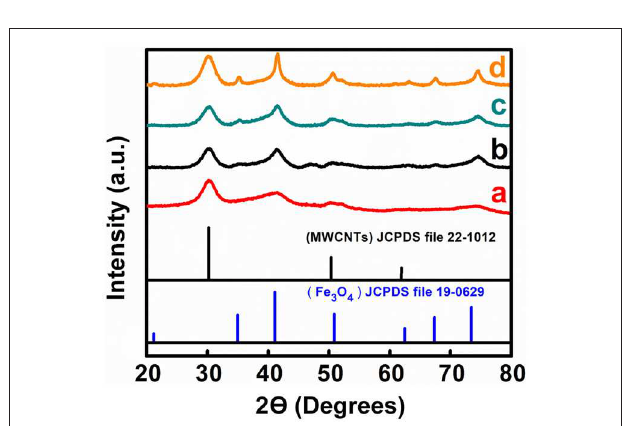
FIGURE 2 | X-ray diffraction patterns of (a) M-CB-MWCNT, (b) M-PV-MWCNT, (c) M-AA-MWCNT, and (d) M-CP-MWCNT.